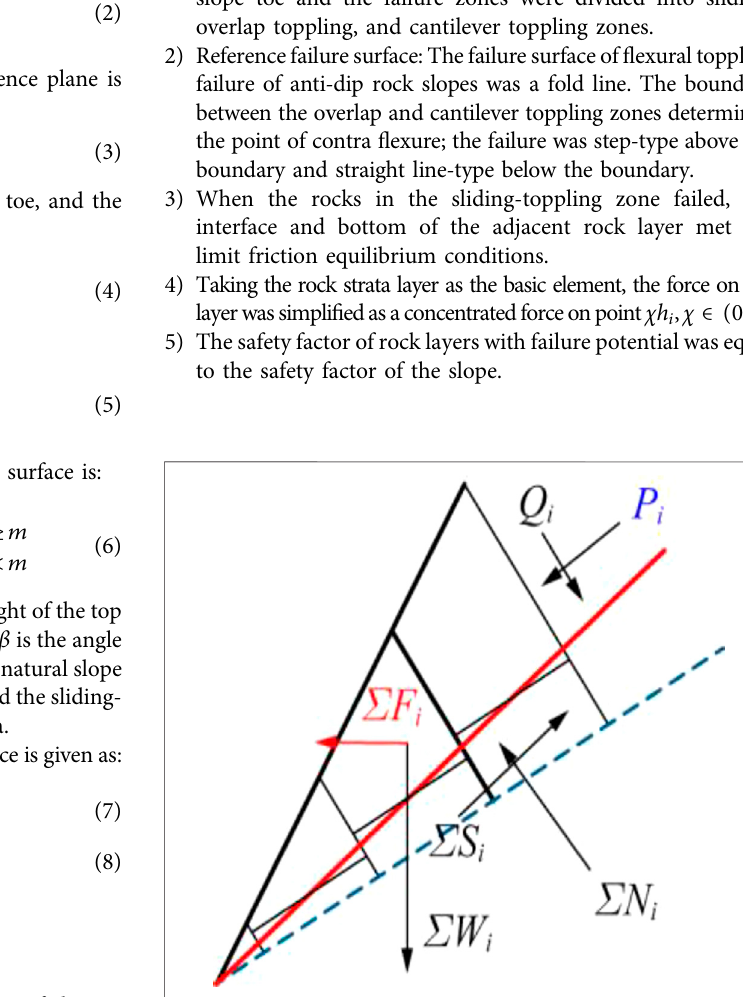
Frontiers in Earth Science |